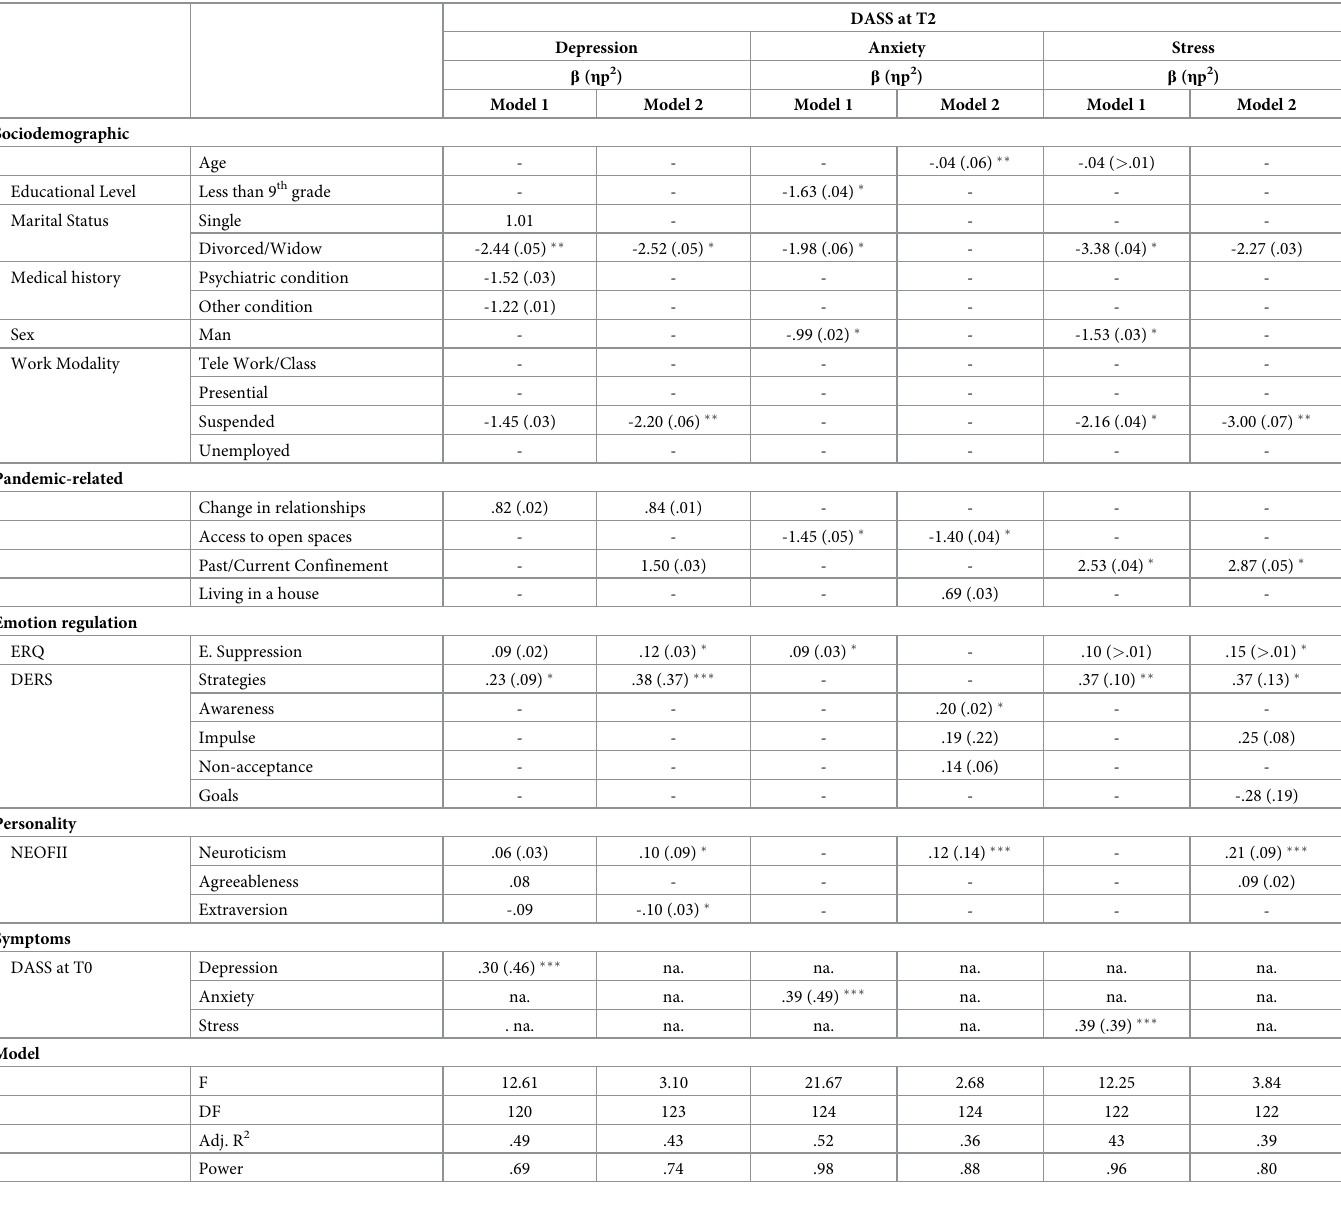
Table 2. Stepwise linear models on personality and emotional regulation skills at T0 as predictors for psychological distress at